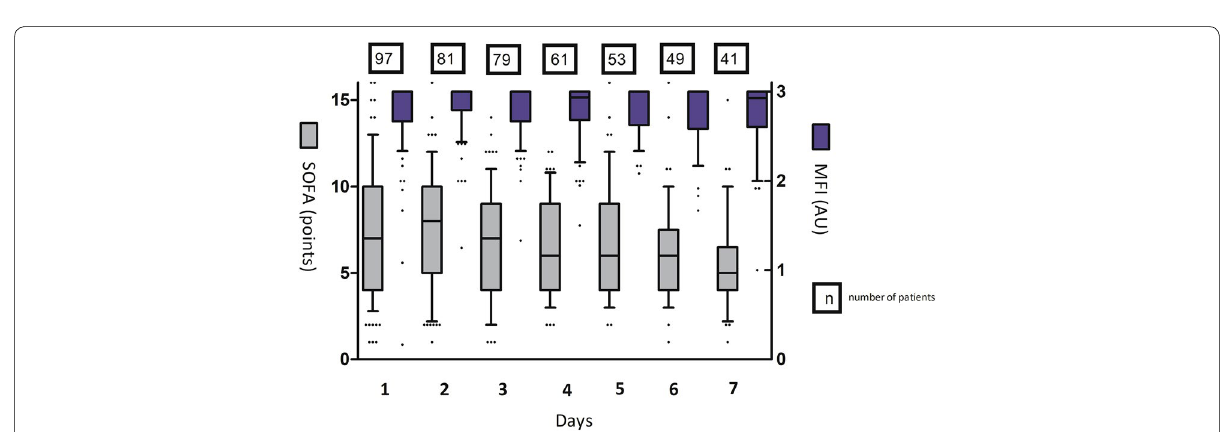
Fig. 3 Evolvement over time of sequential organ failure assessment (SOFA) score and Microvascular Flow Index (MFI) in the first 7 days of ICU admission. Box and 10–90th percentile whisker plots with individual